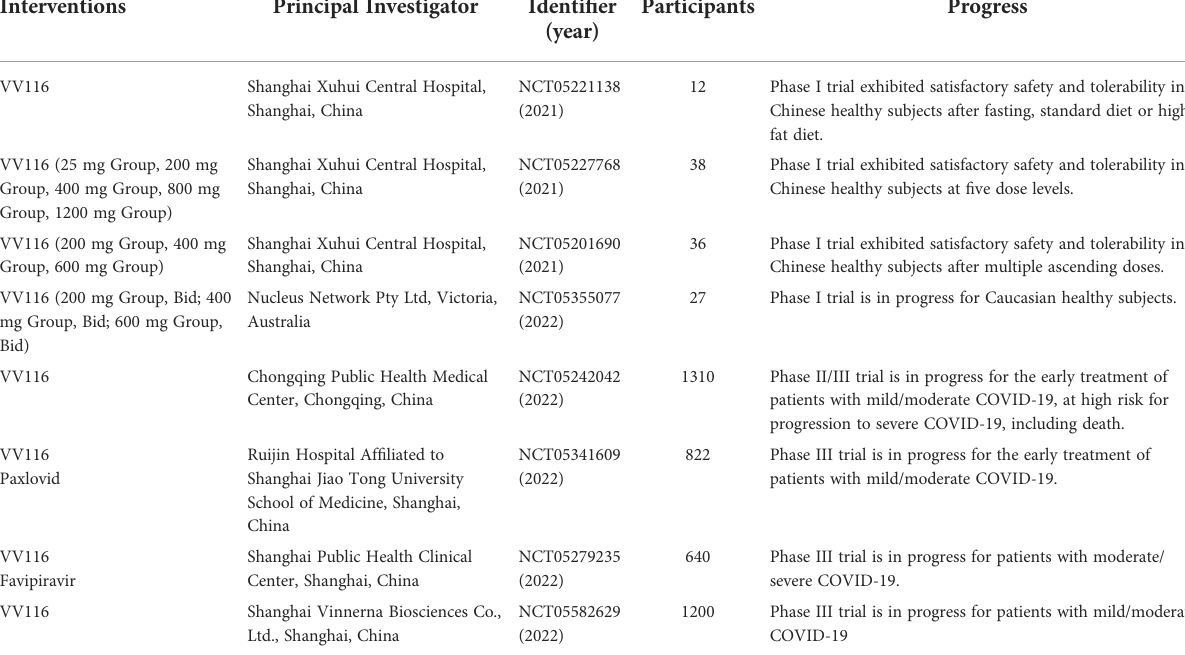
TABLE 2 VV116 in clinical development based on a systematic search of ClinicalTrials.gov (https://clinicaltrials.gov/, accessed 31 October, 2022).